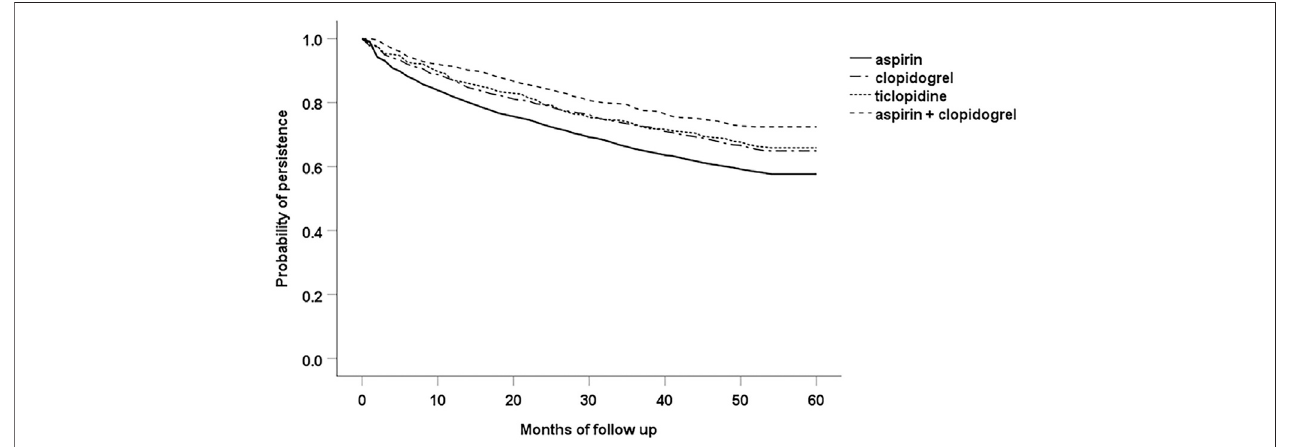
FIGURE 2 | Persistence among the groups of patients with particular antiplatelet agents used at the index date of the study.